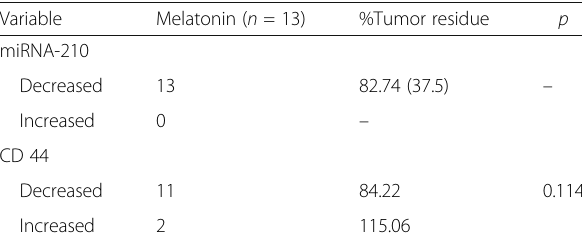
Table 3 Effect of melatonin to biomarker concentration and tumor residue